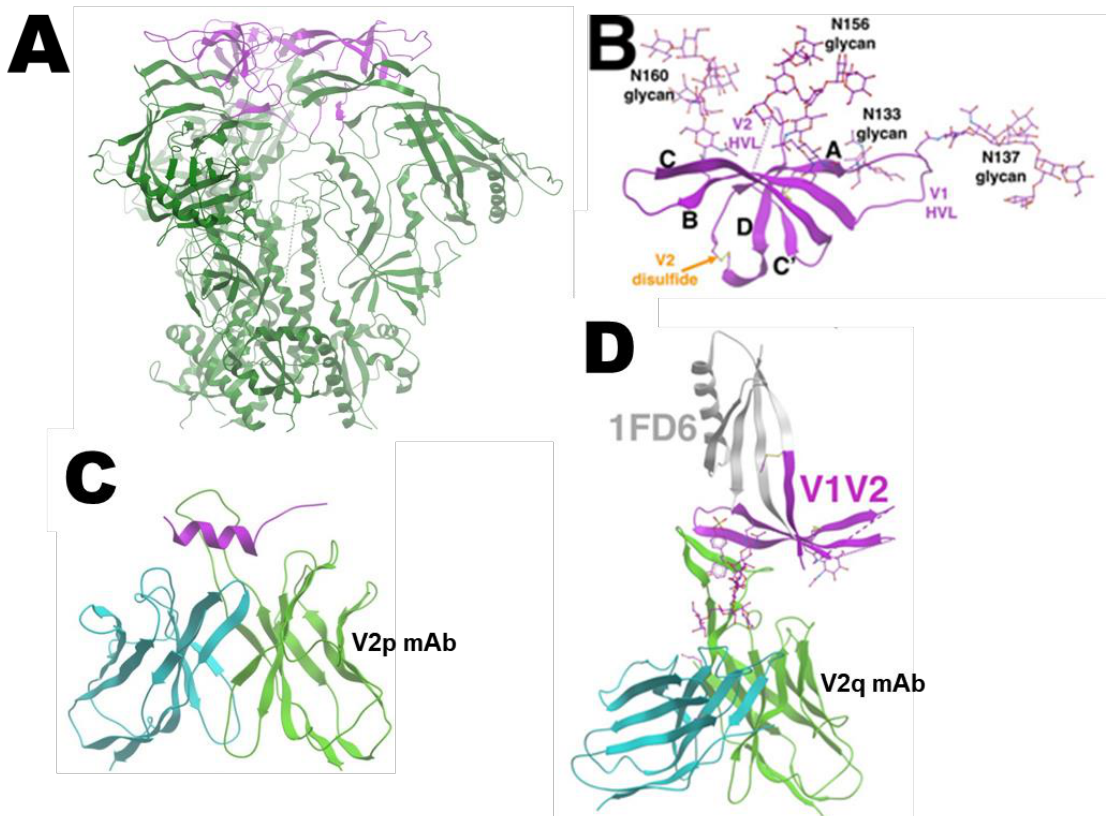
Figure 2. V1V2 structure. ( A ) Three V1V2 domains create the apex of HIV-1 Env. PDB: 6VY2 [64]. ( B ) Each V1V2 is a 5-strand β -barrel. PDB: 4YWG [59]. ( C ) The V2 C-strand is α -helical, when bound by V2p mAb. PDB: 4HPO [62]. ( D ) The binding of V1V2 apex or V2q mAbs like PG9 requires that the C-strand assume a β -sheet conformation. PDB: 3U36 [59]. Purple: V1V2, dark green: gp120 and gp41 subunits beyond V1V2, green and cyan: heavy and light chains of mAbs, gray: 1FD6 scaffold.